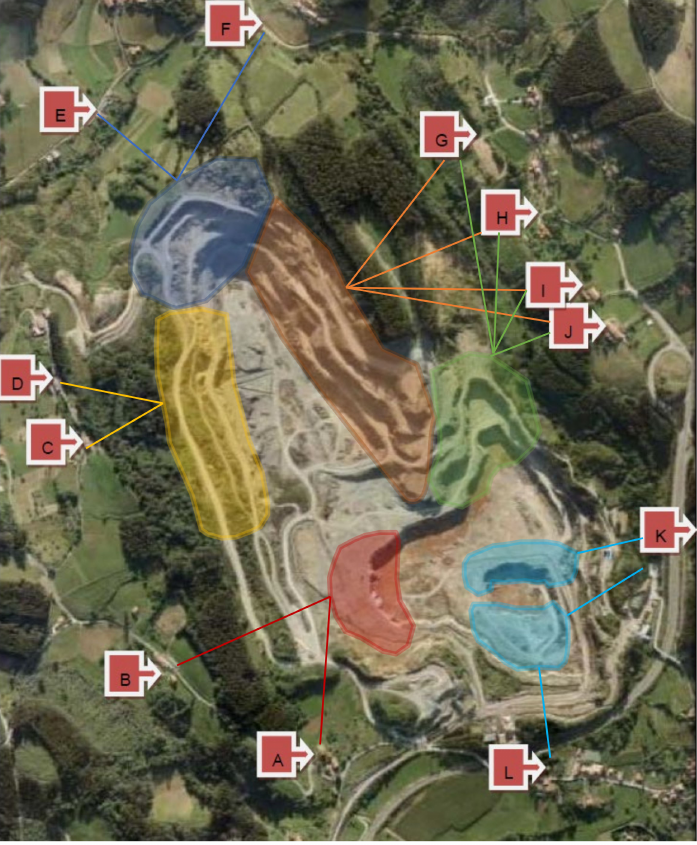
Figure 4. Placement of the recording points around the quarry and influencing